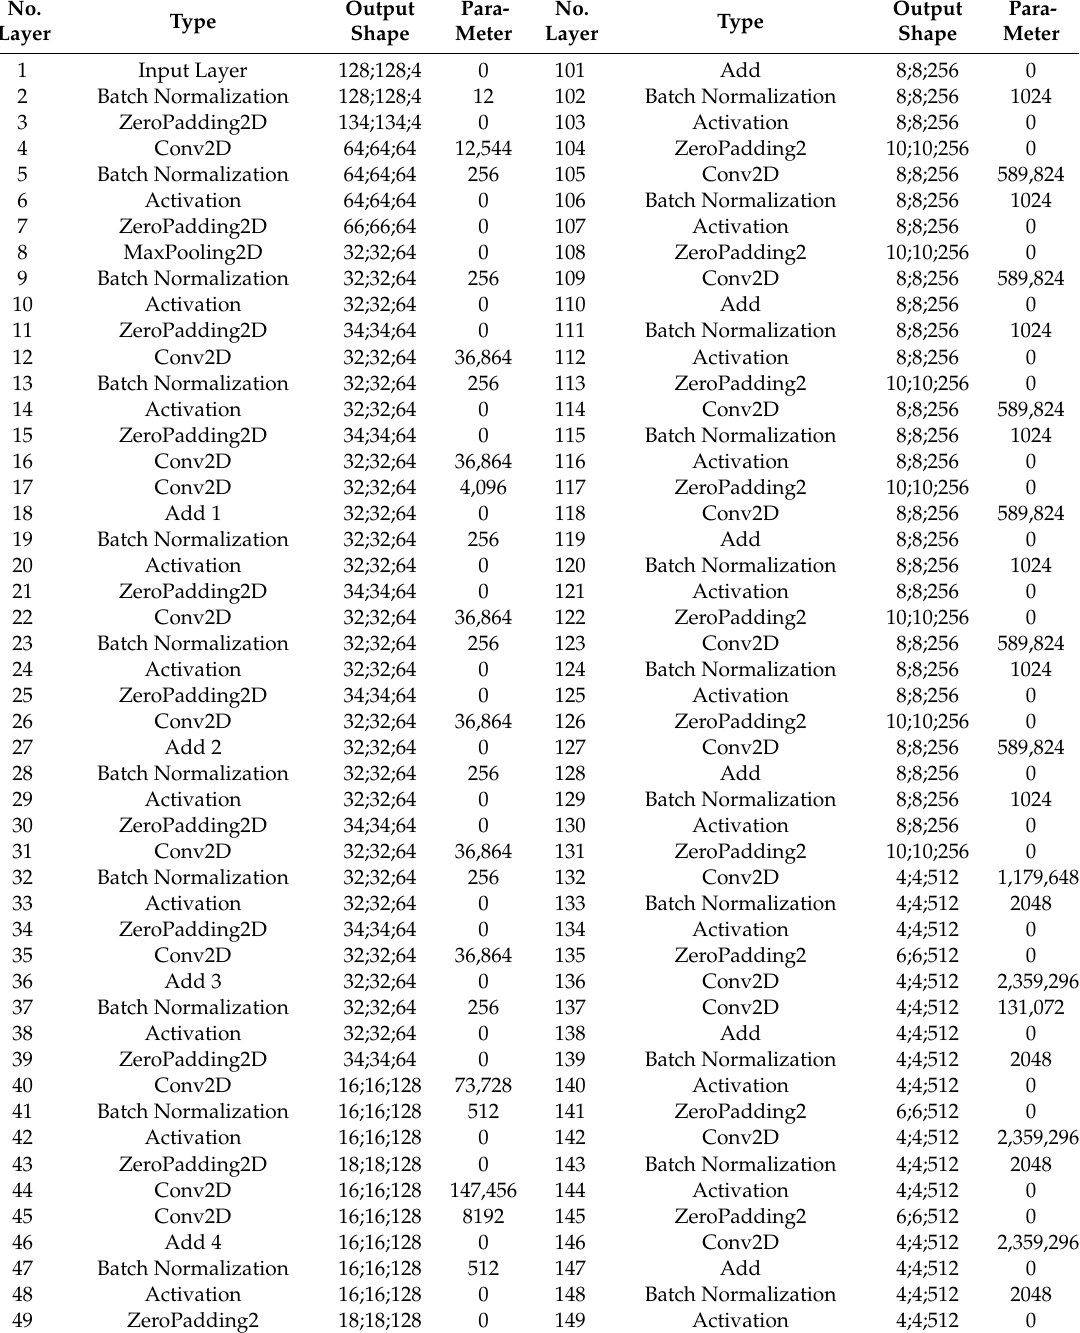
Table A1. Information of 199 layers to train ResU-Net model for wetland